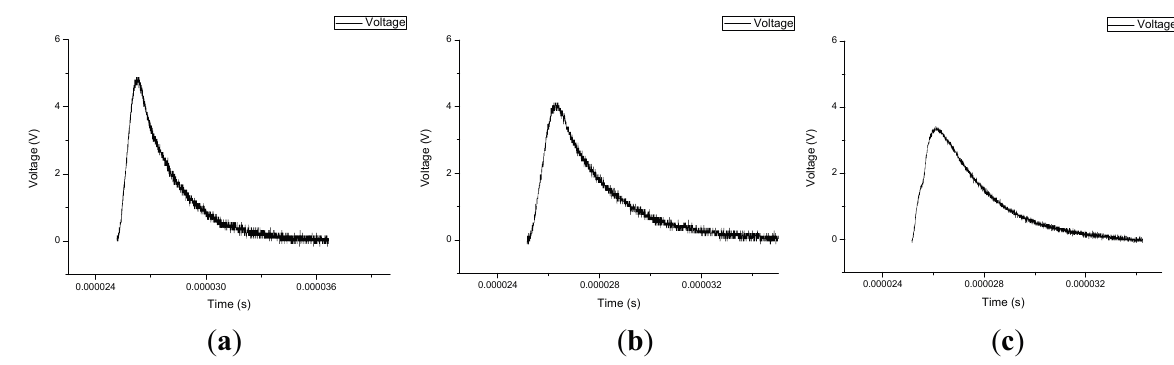
Figure 2. Echo signals with different installation conditions.